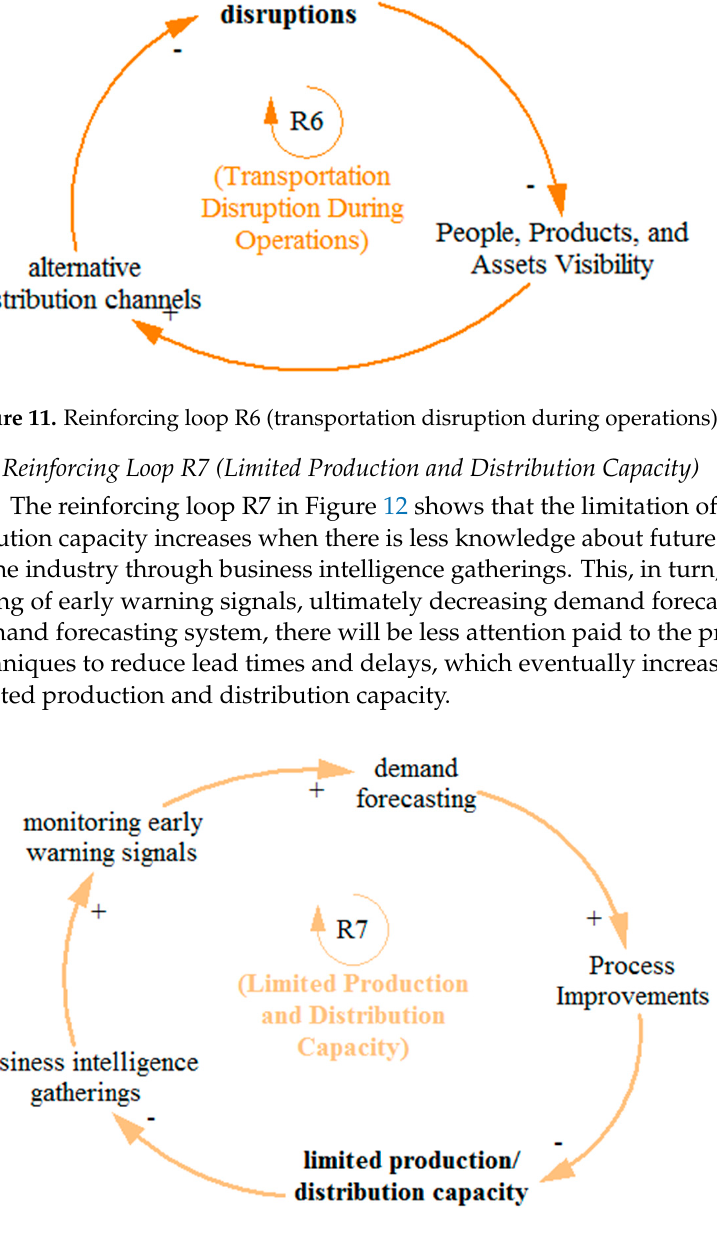
Figure 12. Reinforcing loop R7 (limited production and distribution capacity).